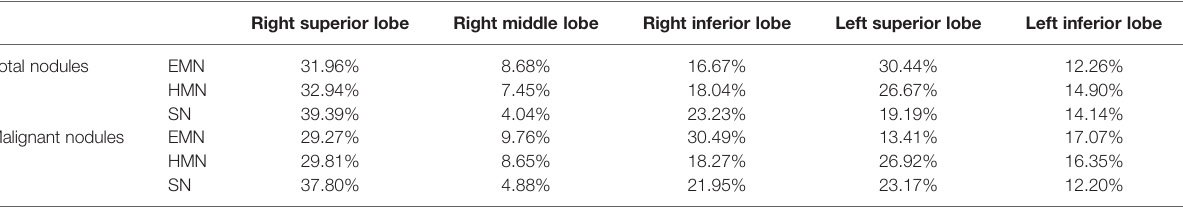
TABLE 2 | Percentage distribution of the pulmonary nodules.